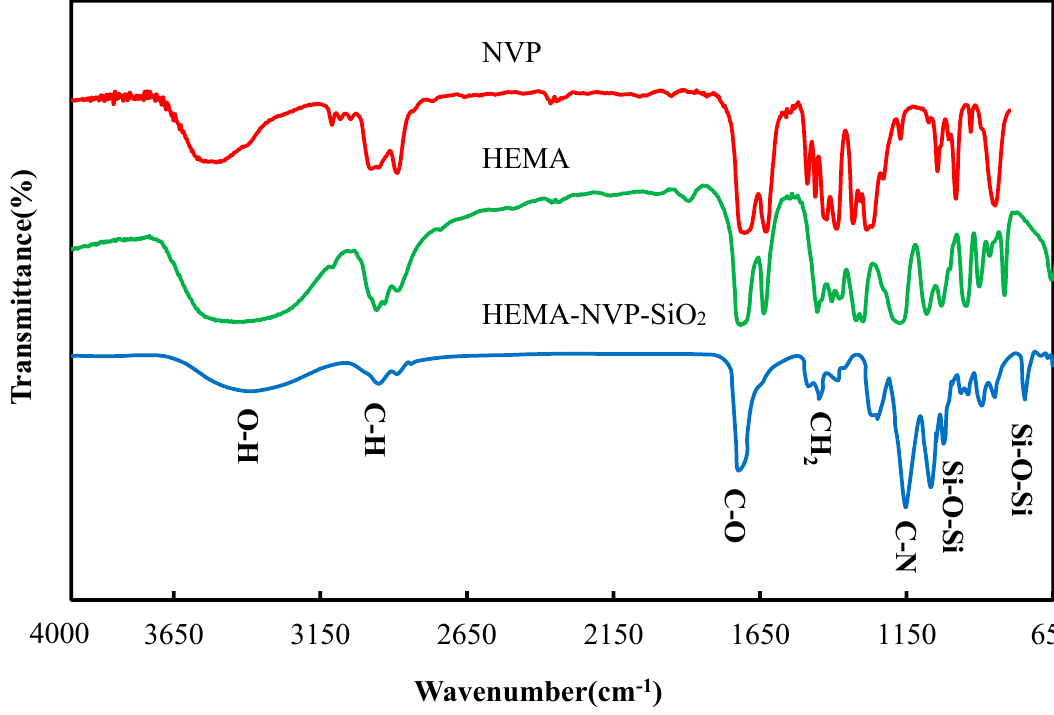
Figure 4. FTIR spectra of SNPs lenses.